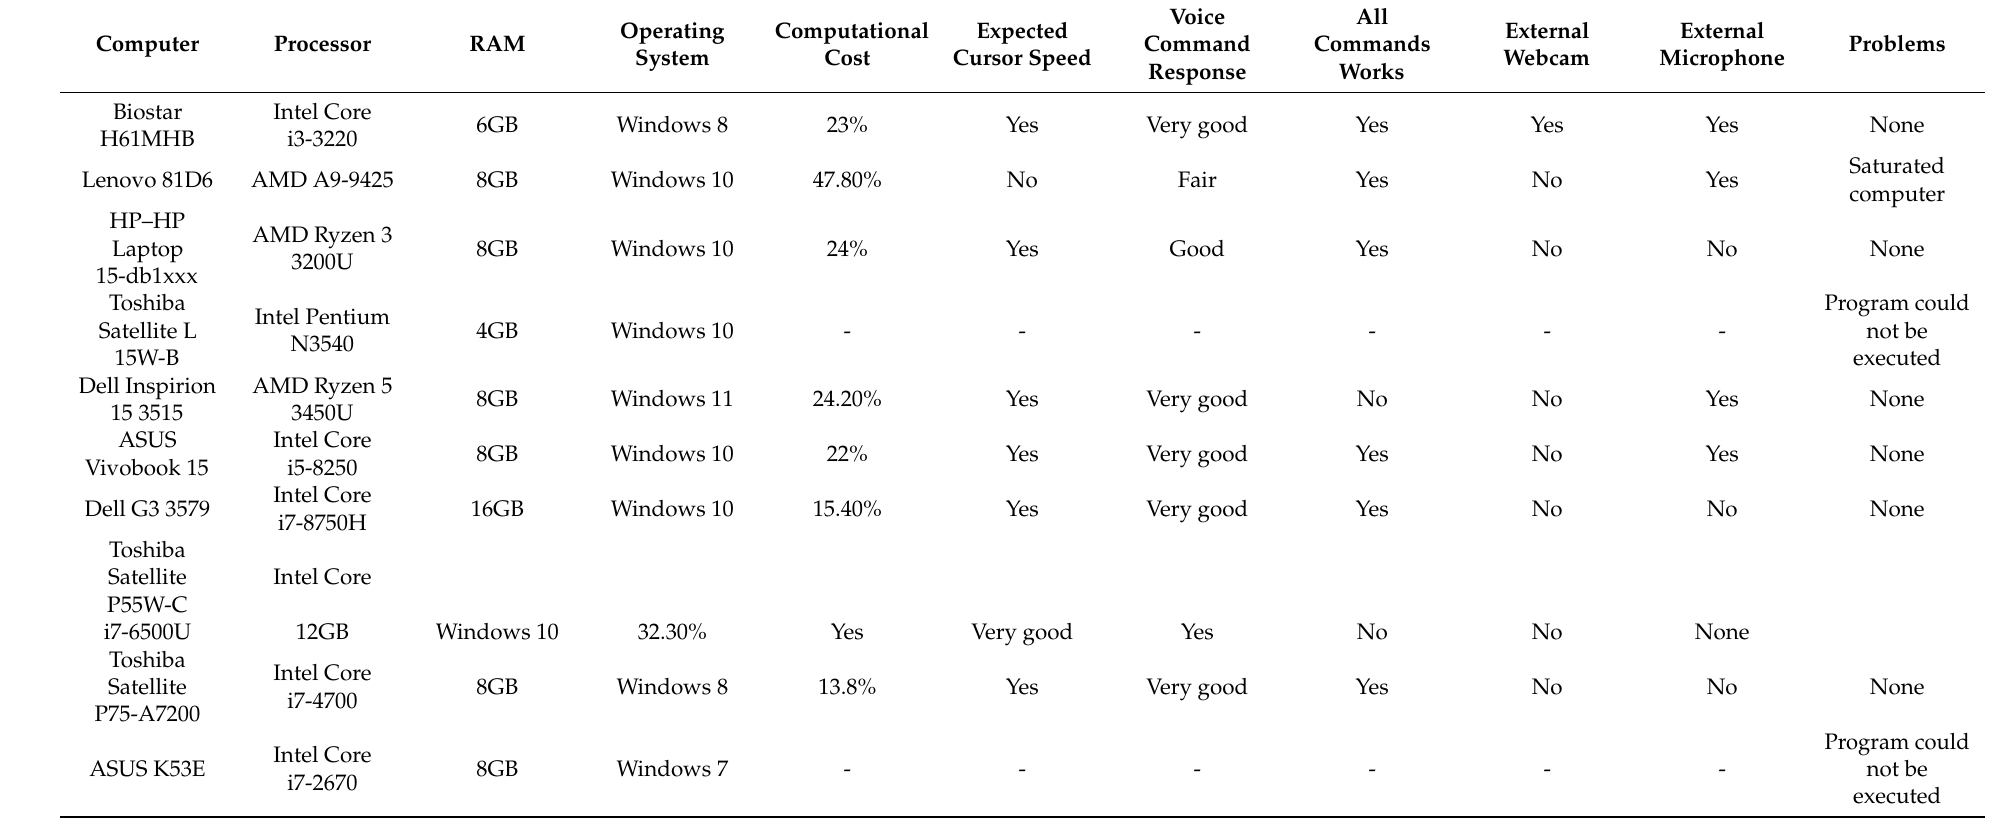
Table 5. Test results using computers with different